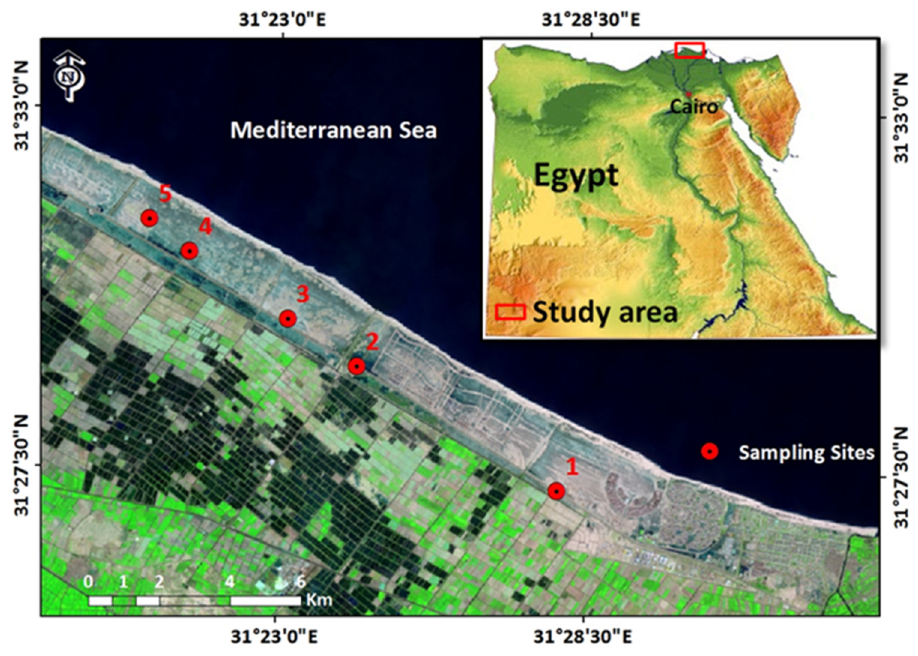
Figure 2. Map showing the different habitats and collection locations of the five halophytes. Table 1. Scientific name, life span, life from, chorotype, and habitats of the studied halophytes